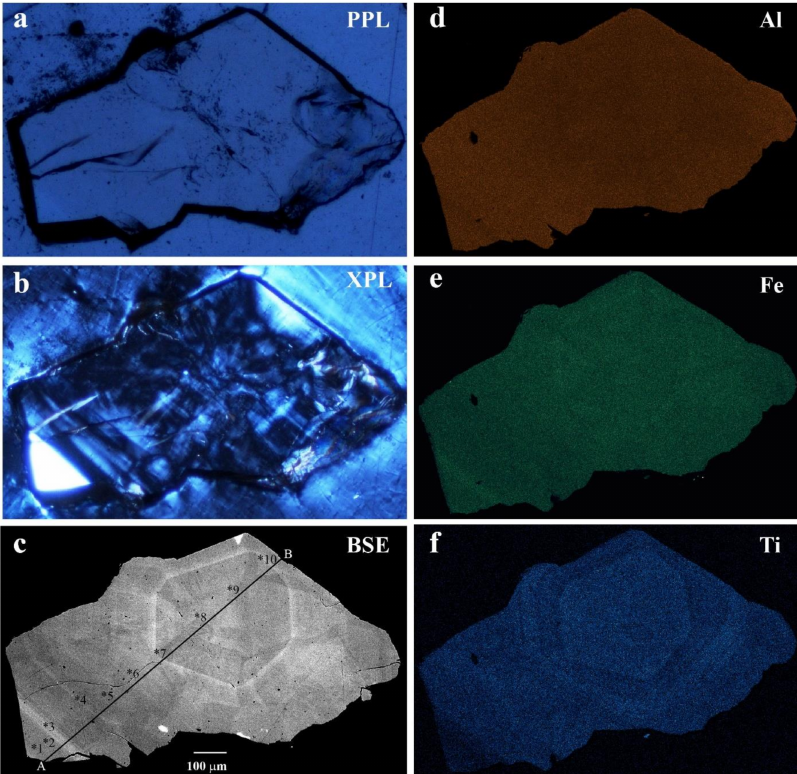
Figure 9. Images for sample-6 from Aosta, Italy. Thin-section images are in ( a ) plane-polarized light (PPL) and ( b ) cross- polarized light (XPL) that shows birefringence. ( c ) The BSE image contains light and dark contrasts that indicate different compositions. The X-ray elemental maps show the distribution of ( d ) Al, ( e ) Fe, and ( f ) Ti atoms. Chemical analyses were obtained from the points marked 1 to 10 in ( c ). Concentric growth features are observed in the BSE image and in the atom distribution maps. Subtle compositional differences are observed. The BSE image, elemental maps, and optical images have the same orientation and scale. The scale bar in ( c ) represents 100 µ m.